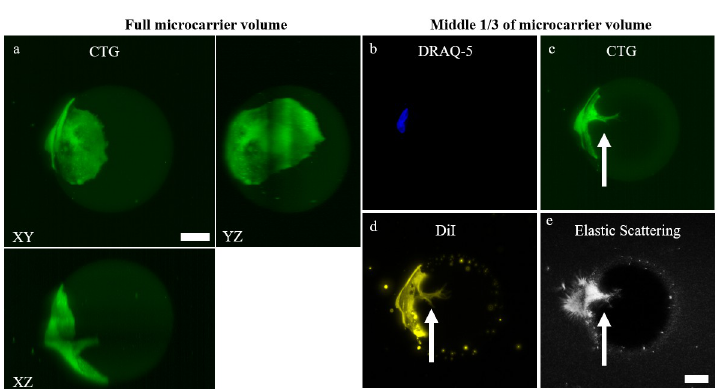
Fig 2. The optical sectioning capabilities of LSM permits visualization into the hydrogel microcarrier. a) 2D max. intensity and orthogonal projection of P7 D3 microcarrier with a single CTG-expressing cell. 2D max. intensity projections using the middle 1/3 of the volume to view the interior of the microcarrier using b) DRAQ-5, c) CTG, d) DiI plasma membrane stain, and e) elastic scattering contrast. Owing to the optical sectioning capabilities of LSM and refractive index matching of the microcarriers, biological features such as cell infiltration into the microcarrier can be visualized (white arrow). Scale bar = 25 μ m.